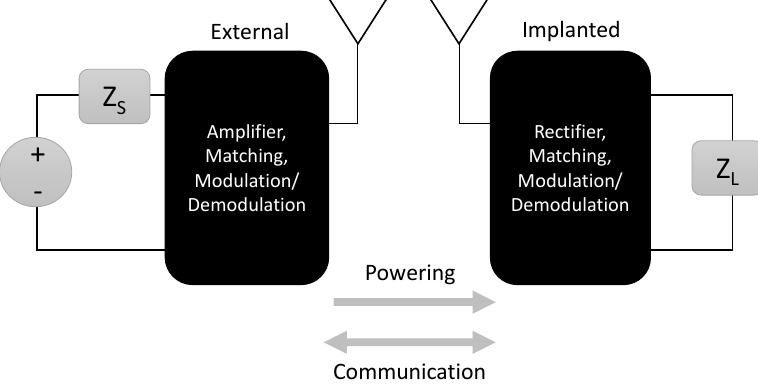
Figure 2. Simplified general wireless transcutaneous system